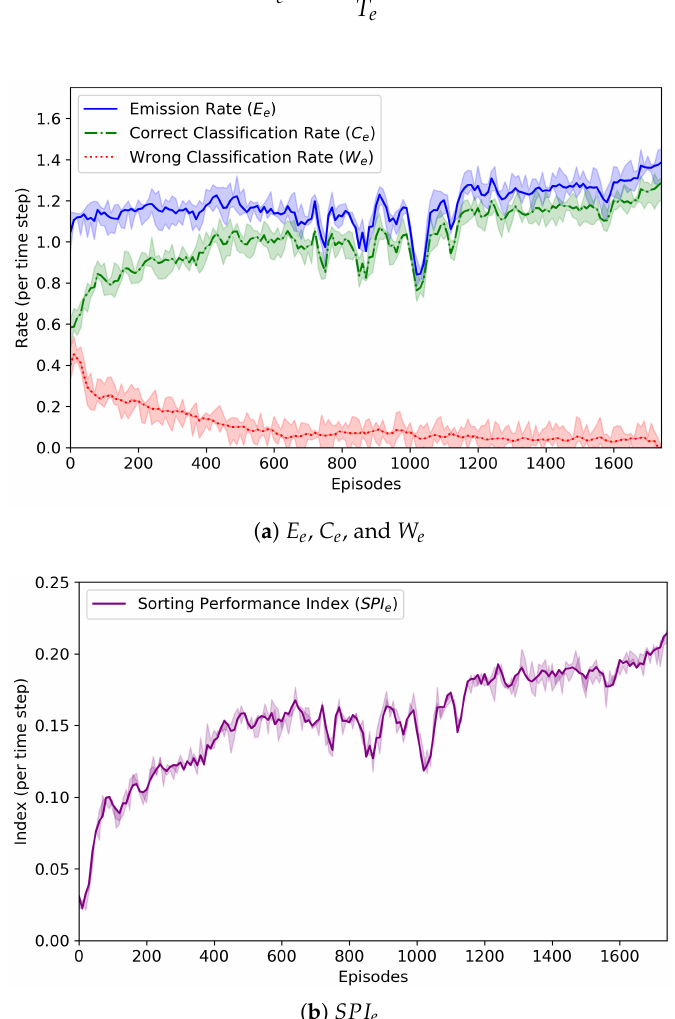
Figure 5. The change of average emission rate ( E e ), average correct classification rate ( C e ), average wrong classification rate ( W e ), and sorting performance index ( SPI e ). We conducted seven experimental runs. The graphs include the lines plotted for the average values of the four measures, while the shaded areas of the upper and lower limits are the maximum and minimum values for the same